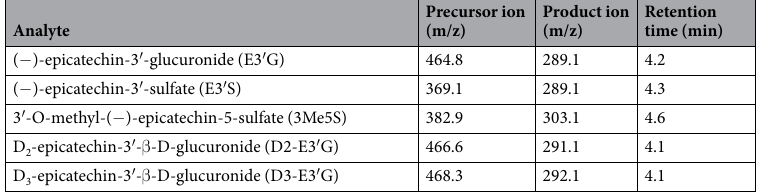
Table 2. LC-MS parameters for analytes and internal standards considered in method including precursor and product ions (m/z) and typical retention